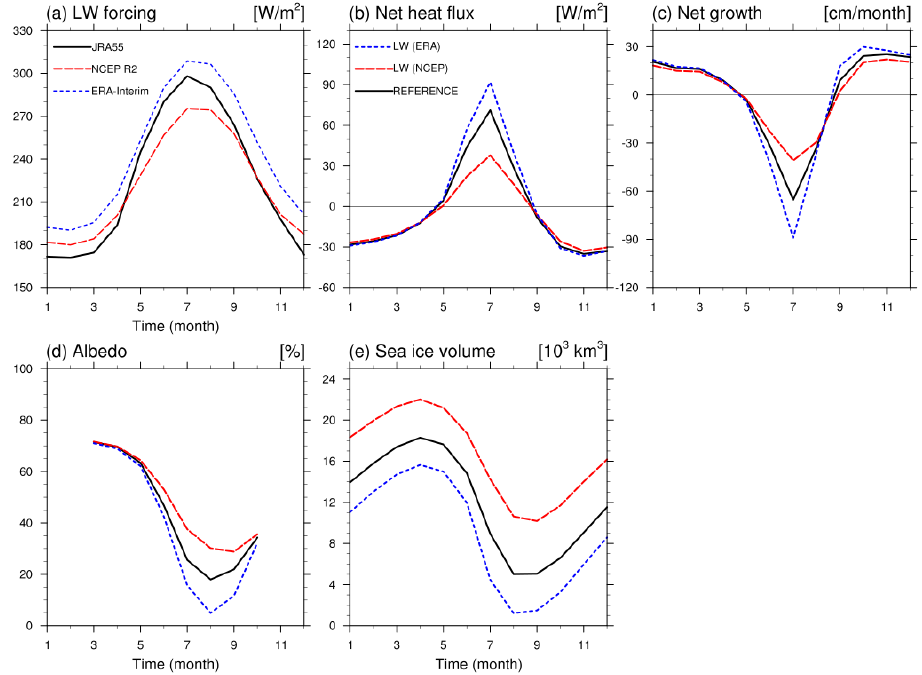
Figure 4. Comparison of the LW experiments. ( a ) Downward longwave radiative forcing (similar to Figure 1b), ( b ) net heat flux, ( c ) net growth rate of sea ice, ( d ) areal mean of snow and ice surface albedo from the available shortwave radiation, and ( e ) sea ice volume. The ice surface albedo is shown from March through October because the shortwave radiation is zero for most areas in winter (from November through February). ( c – e ) use the same labels as ( b ).